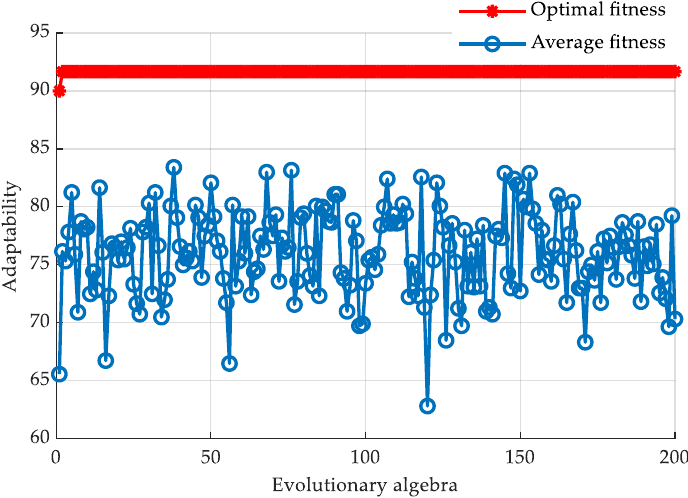
Figure 11. Fitness curves of PSO classification.